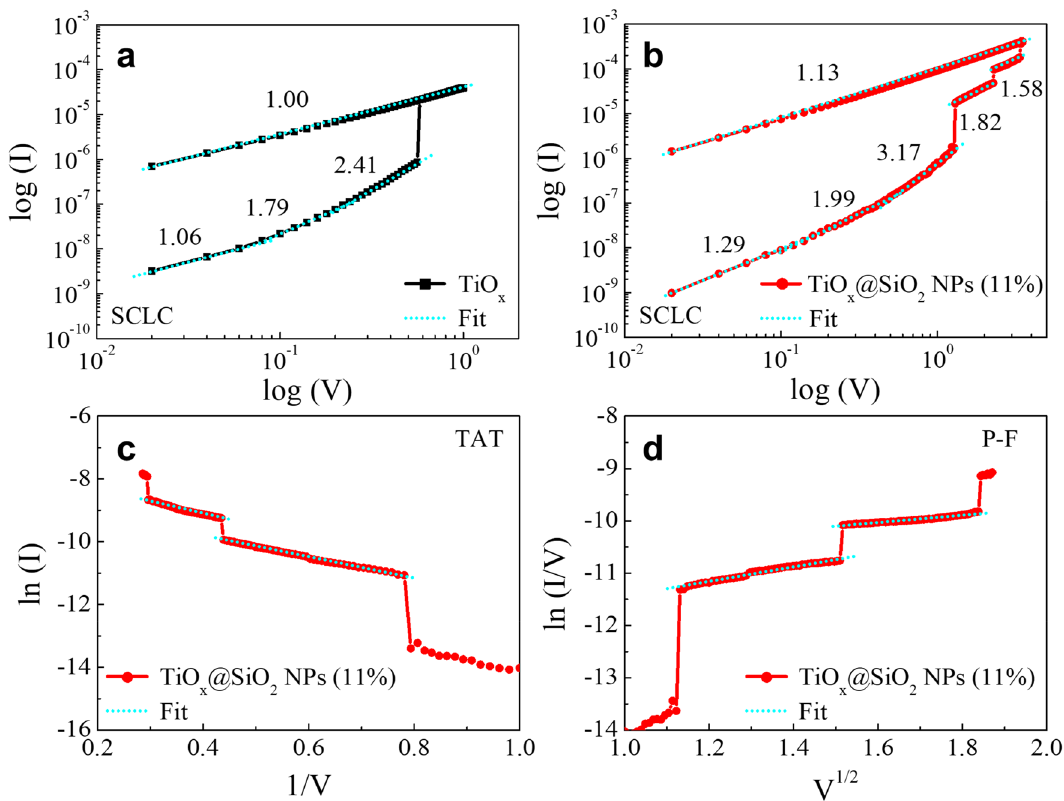
Figure 6. Log I–log V plot of I–V curves of the ( a ) TiO x and ( b ) the TiO x @SiO 2 NPs switching devices. The TiO x @SiO 2 NPs implies ( c ) trap-assisted tunneling, and ( d ) Poole–Frenkel emission in the high-voltage